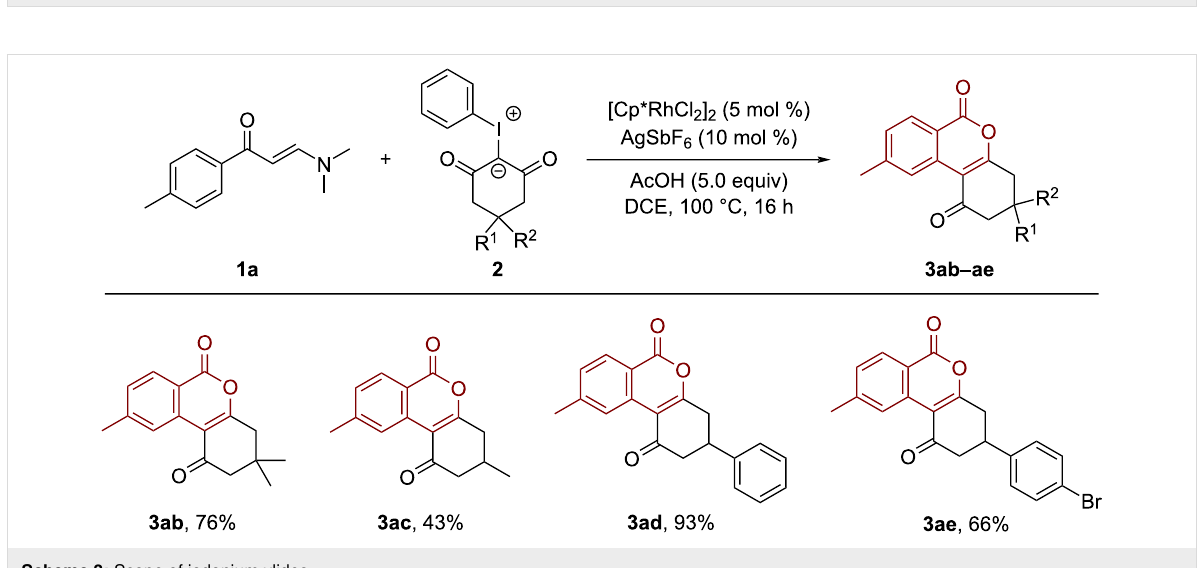
Scheme 2: Scope of enaminones.